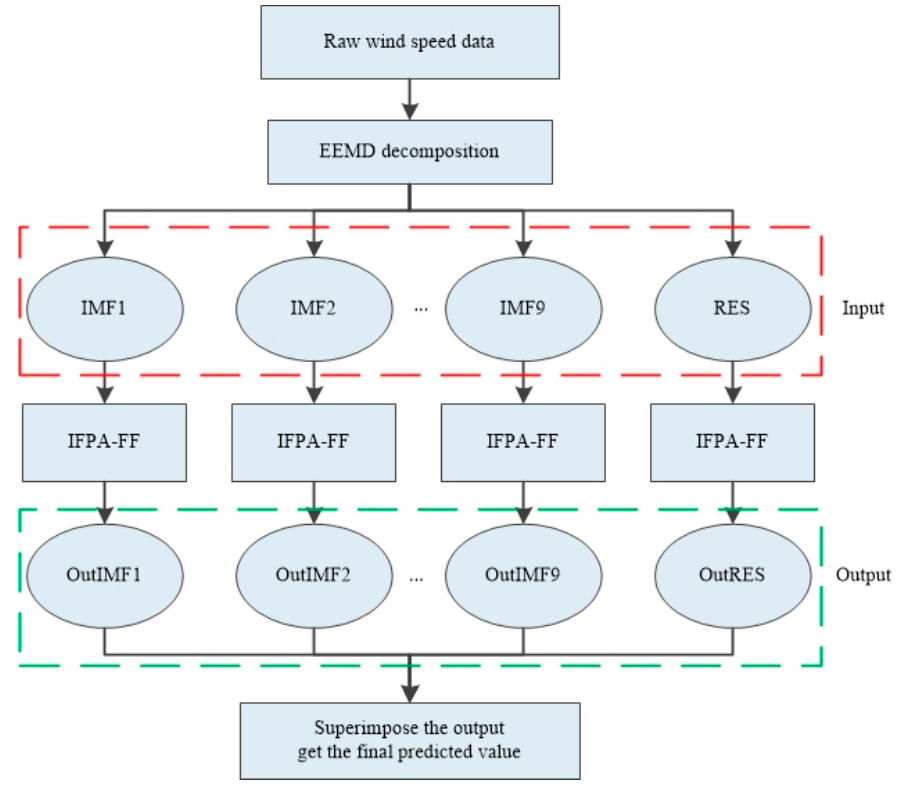
Figure 10. Flowchart of the prediction model.